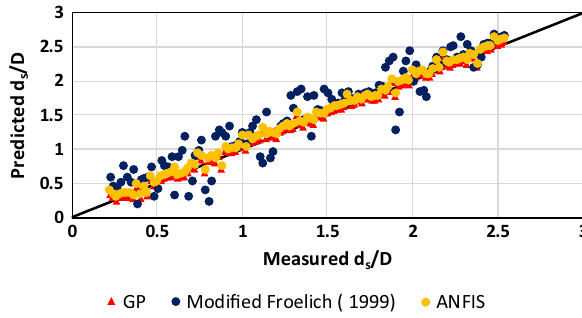
Fig. 6 ANFIS- and GP-predicted values of d values